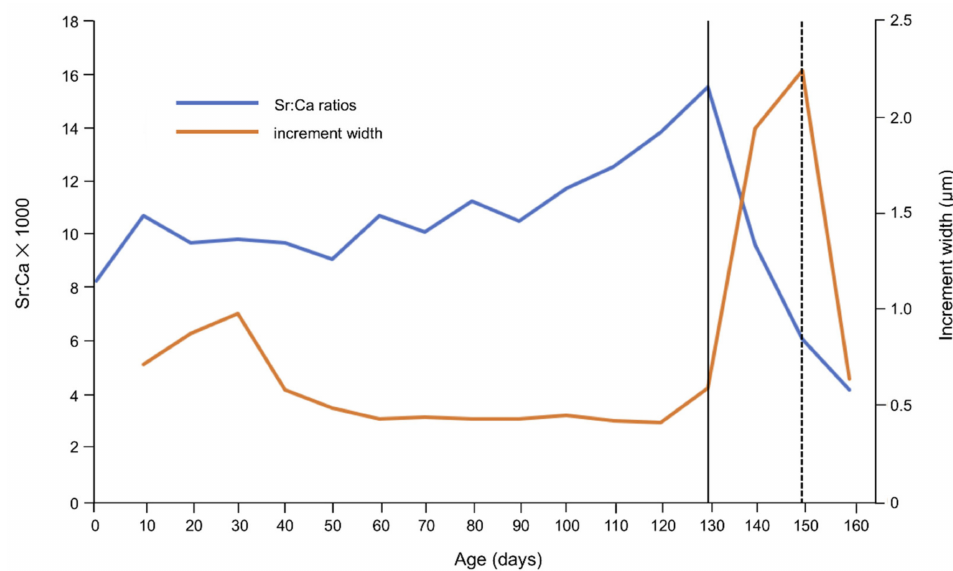
Figure 3. A profile shows fluctuations in otolith Sr:Ca ratios (blue line) and widths of otolith